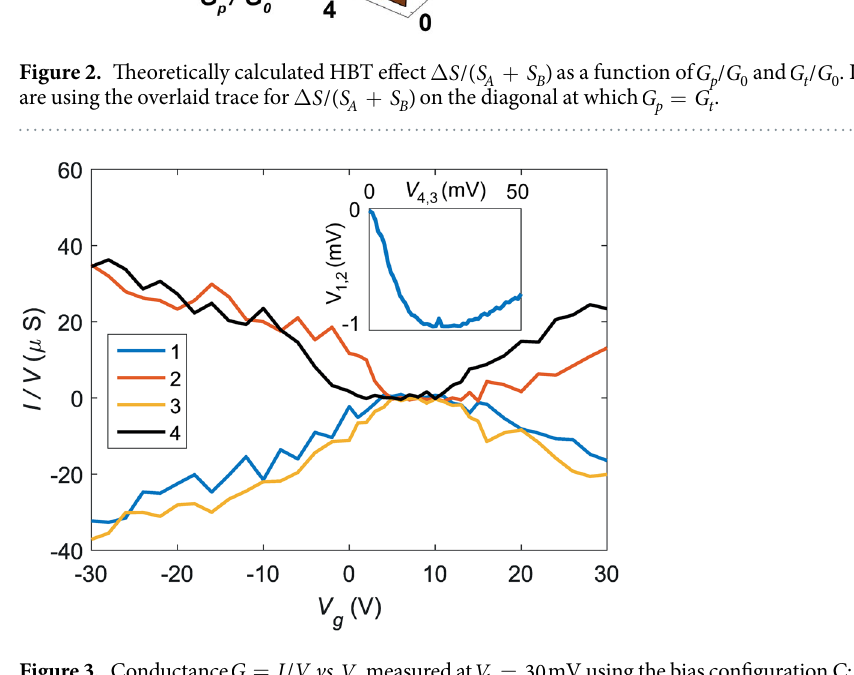
Figure 3. Conductance = G I V / vs . V I 2 and I 4 are positive, while < I 0 1 and < I 0 3 . The inset at = − V 30